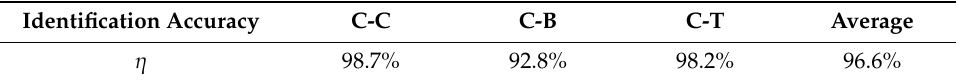
Table 3. Accuracy of vehicle type